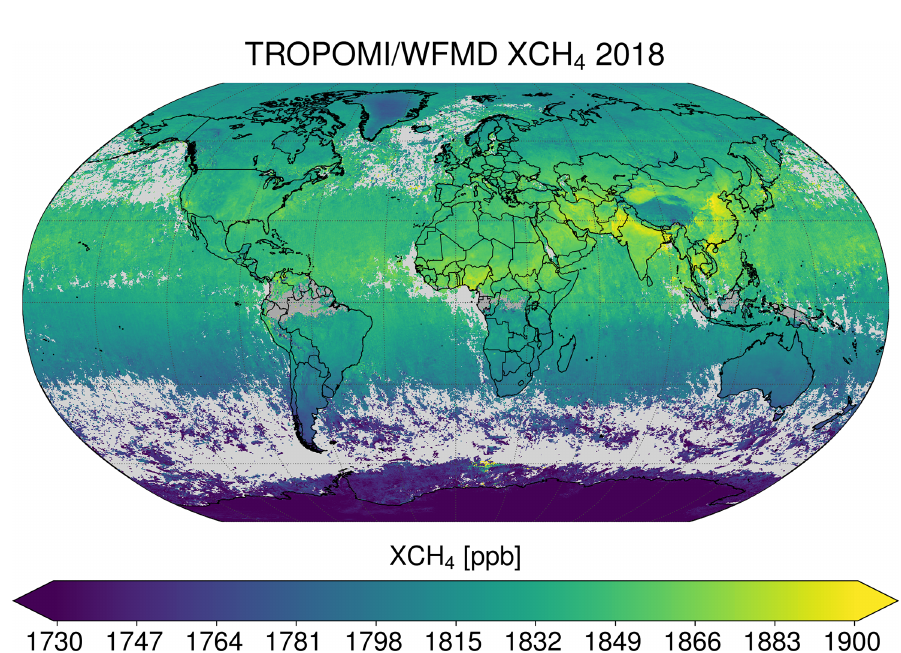
Figure 14. Global yearly average of TROPOMI/WFMD XCH 4 for